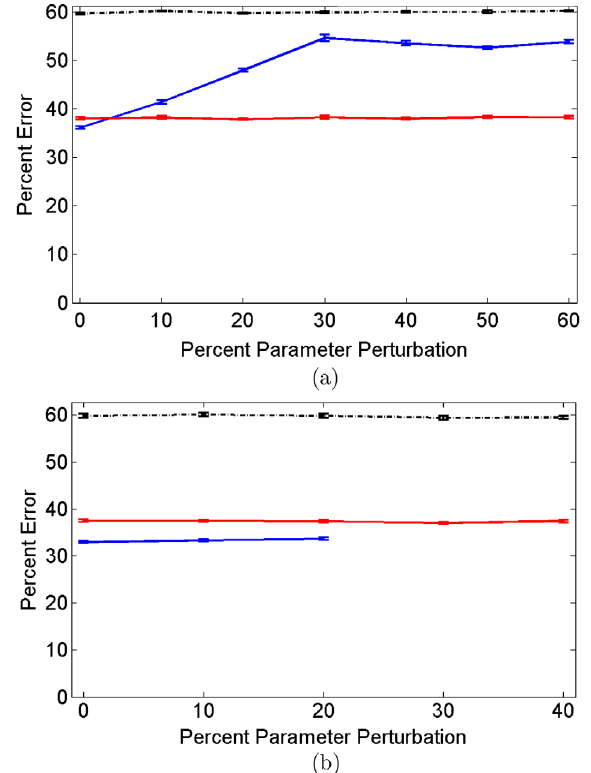
FIG. 8. Under situations of model error, the performance of the parametric filter can degrade rapidly. In our examples, this model error is simulated by perturbing the system parameters. Even under this relatively mild form of model error, it is evident that the parametric filter can have difficulty in filtering a noisy observa- tion. Error bars denote standard error over 10 realizations. (a) Results for filtering the Lorenz-63 x variable when the observations are perturbed by 60% noise (dotted black curve indicates signal error). The performance of the parametric filter (solid blue curve) under slight model error becomes much worse than the Kalman-Takens filter (solid red curve), which is completely robust to any form of model error. (b) Results for filtering the x 1 node in a 40-dimensional Lorenz-96 system when observations are perturbed by 60% noise. Only three data points are shown for the parametric filter because starting at 30% parameter perturbation the filter diverges, once again showing the crippling effect of model error on the performance of the parametric